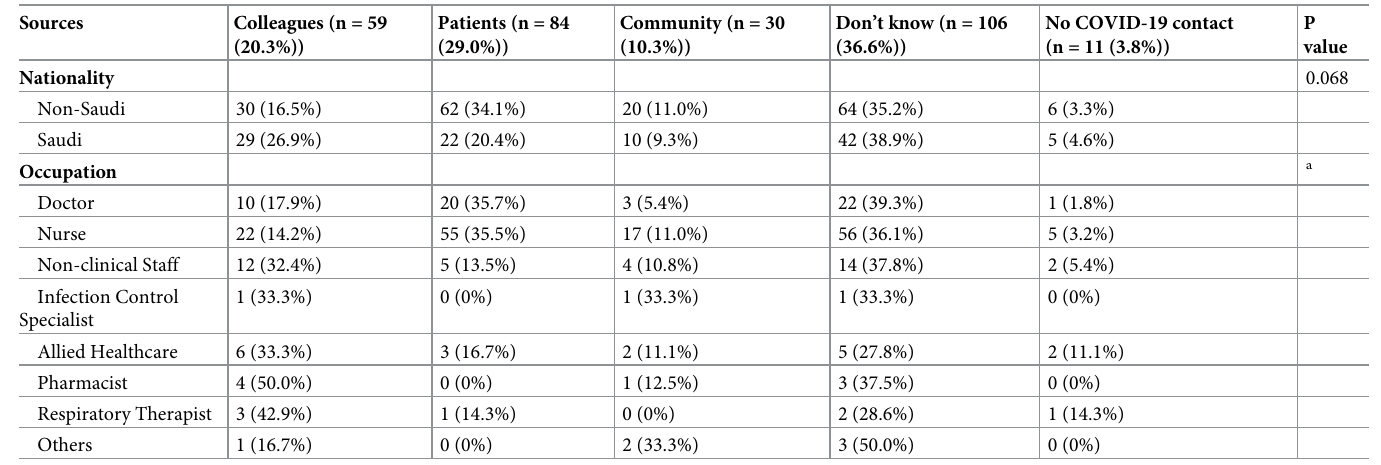
Table 5. Perceived sources of COVID-19 exposure among study participants (n = 290). Sources